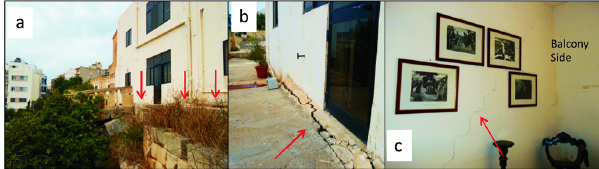
Fig. 4. Cracks and damage in the San Guzepp Haddiem church. (a) The balcony on the southern side of the building; (b) detailed view of the main fracture along the south side of the church; and (c) view of a room inside the